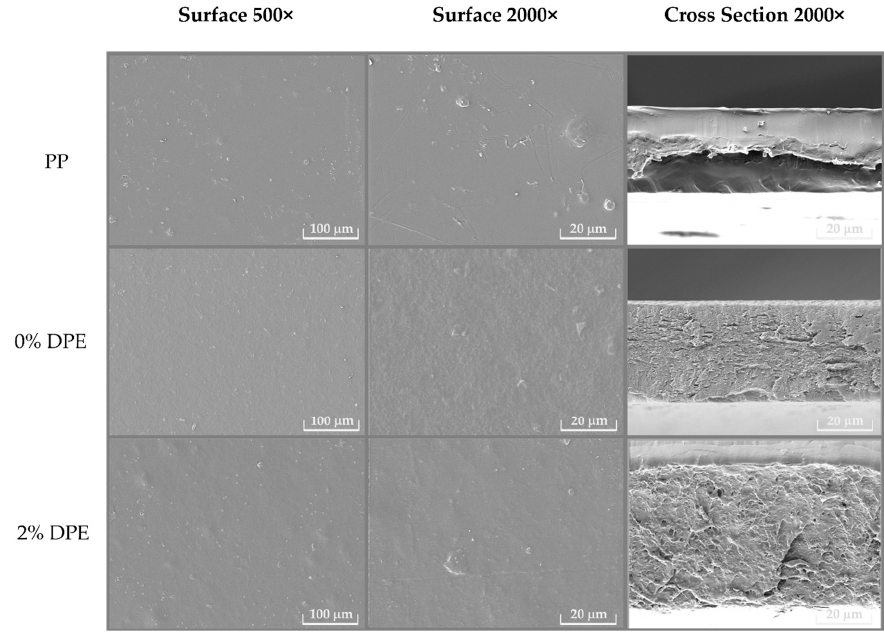
Figure 1. FESEM micrographs of surface (magnification: 500× and 2000×) and cross-section (magni- fication: 2000×) of polypropylene (PP), 0% DPE: 0% dragon fruit peel extract-enriched biocomposite films (% w / v ), 2% DPE: 2% dragon fruit peel extract-enriched biocomposite films (% w / v ).